Question: What type of chart is this?
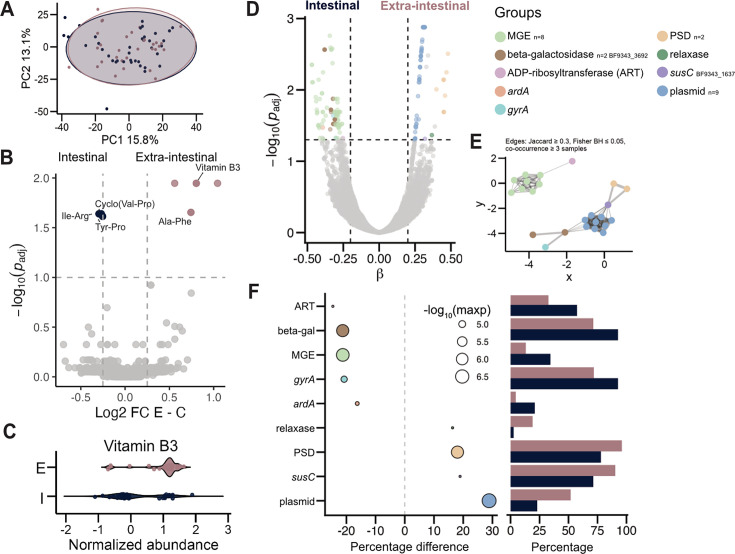
Answer: scatter